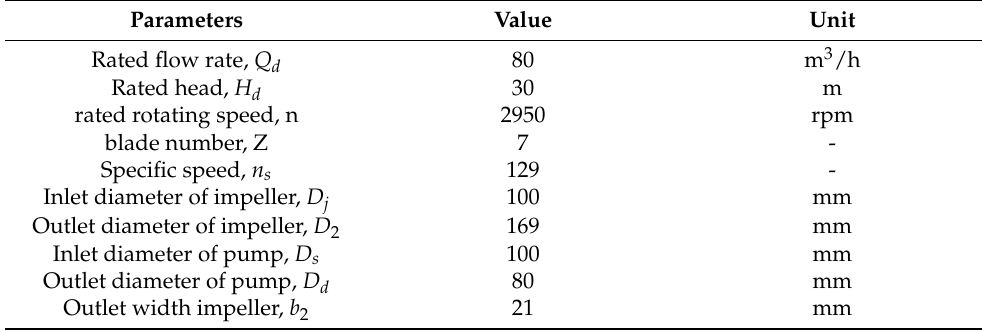
Table 1. Primary parameters of the centrifugal